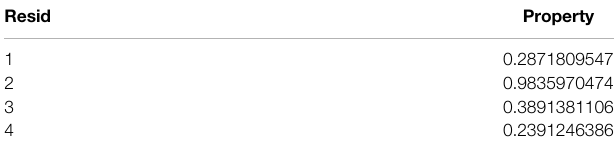
TABLE 1 | Property table example. First column must be formatted with the “ Resid ” header followed by digits indicating each residue for a property to be mapped. The following property columns have header strings and are followed by fl oat or integer numbers indicating the value of a property for each residue of a NaV.